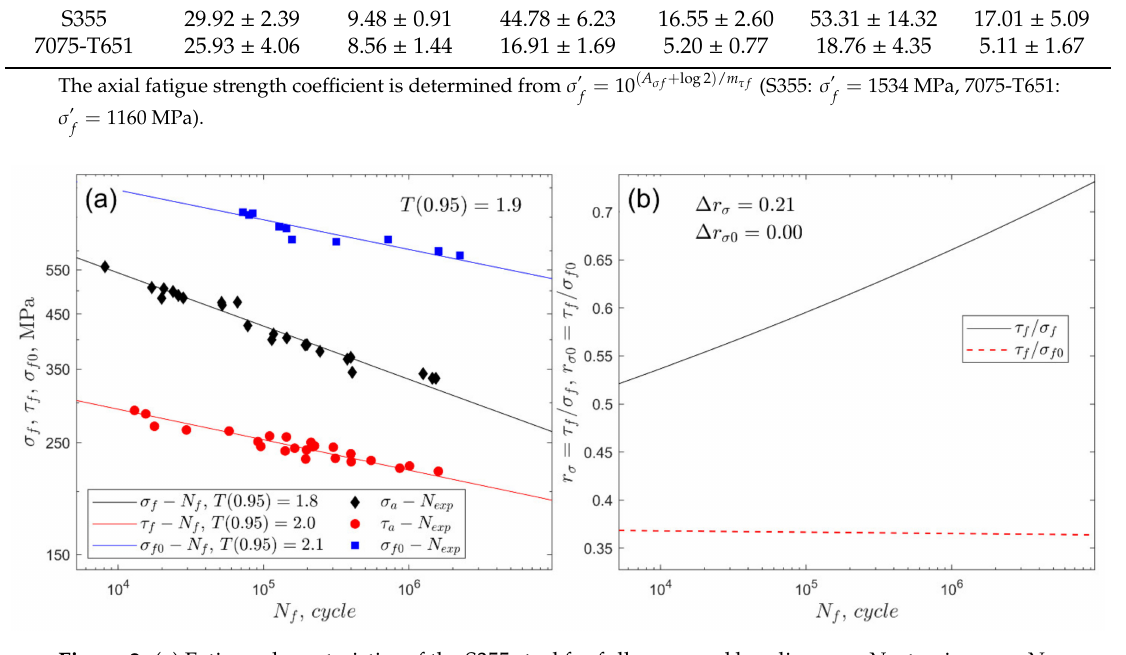
Figure 2. ( a ) Fatigue characteristics of the S355 steel for fully reversed bending σ f − N f , torsion τ f − N f ,